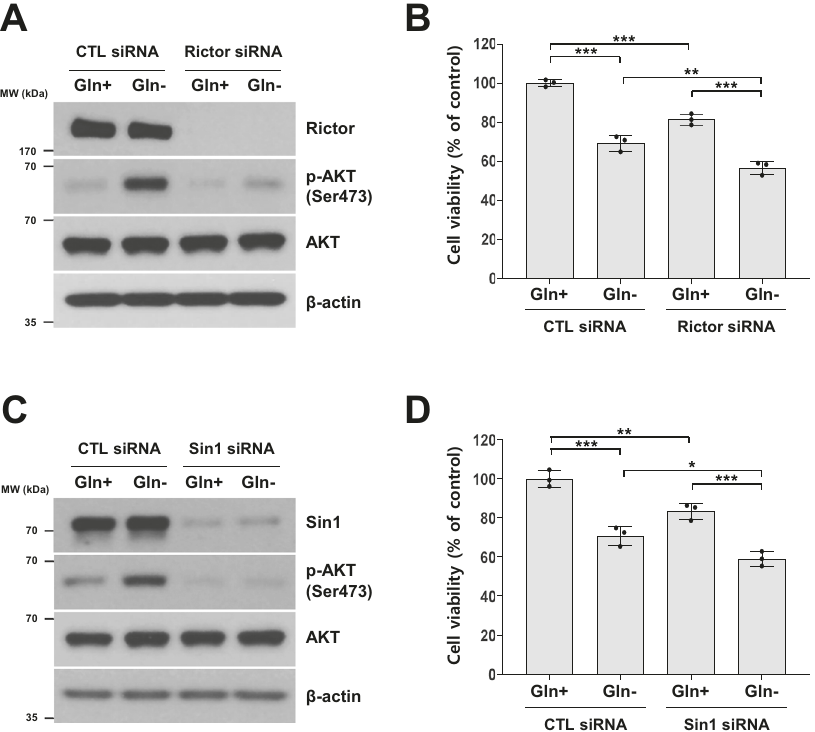
Fig. 6 Inhibition of mTORC2 activity suppresses AKT activation and enhances the inhibitory effects on the viability of glutamine- deprived cells. A – D H1299 cells were transfected with a control, Rictor or Sin1 siRNA for 12 h and then subjected to glutamine deprivation for 24 h. A , C The level of phosphorylated AKT (Ser473) was measured by western blot analysis. B , D Cell viability was measured by MTT assay. The data are presented as the mean percentage of control ± SD relative to the control ( n = 3; * p < 0.05; ** p < 0.01; *** p < 0.001). CTL: